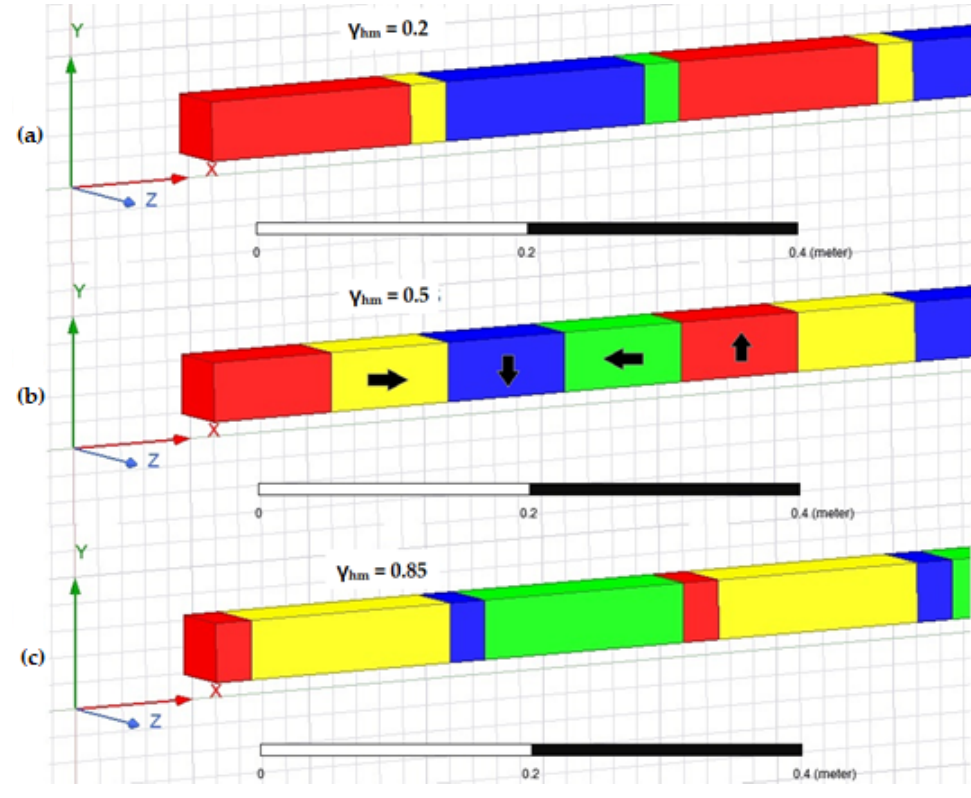
Figure 2. Examples of Halbach arrays with different fill factors. ( a ) γ hm = 0.2, ( b ) γ hm = 0.5 and ( c ) γ hm = 0.85.